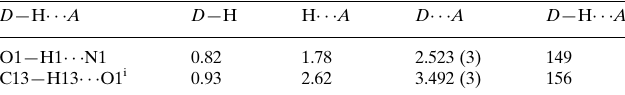
Hydrogen-bond geometry (A˚ , (cid:2)